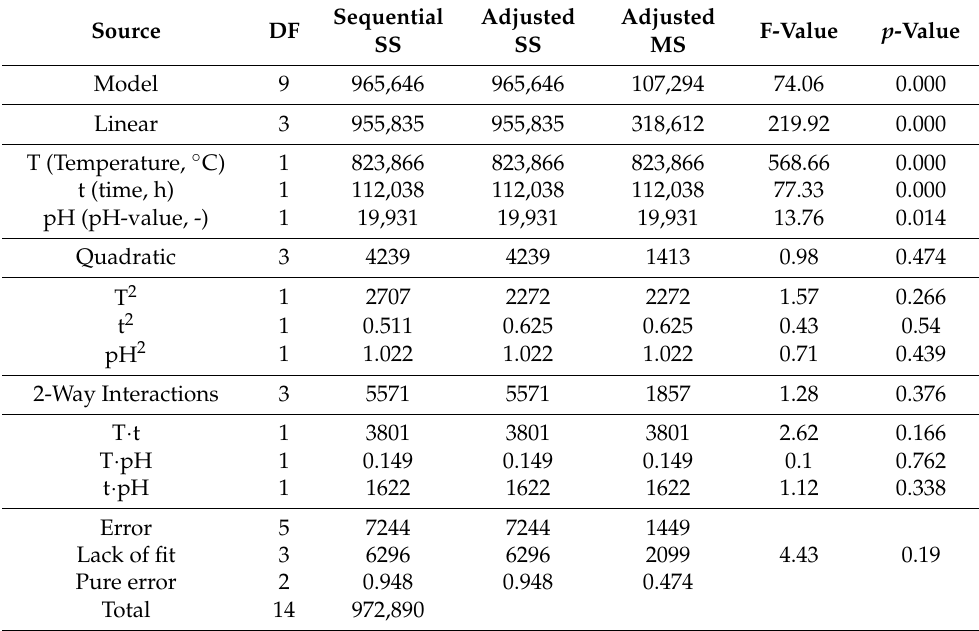
Table A4. ANOVA for the model of NH 4 -N/TN. DF: degrees of freedom, SS: sum of squares,